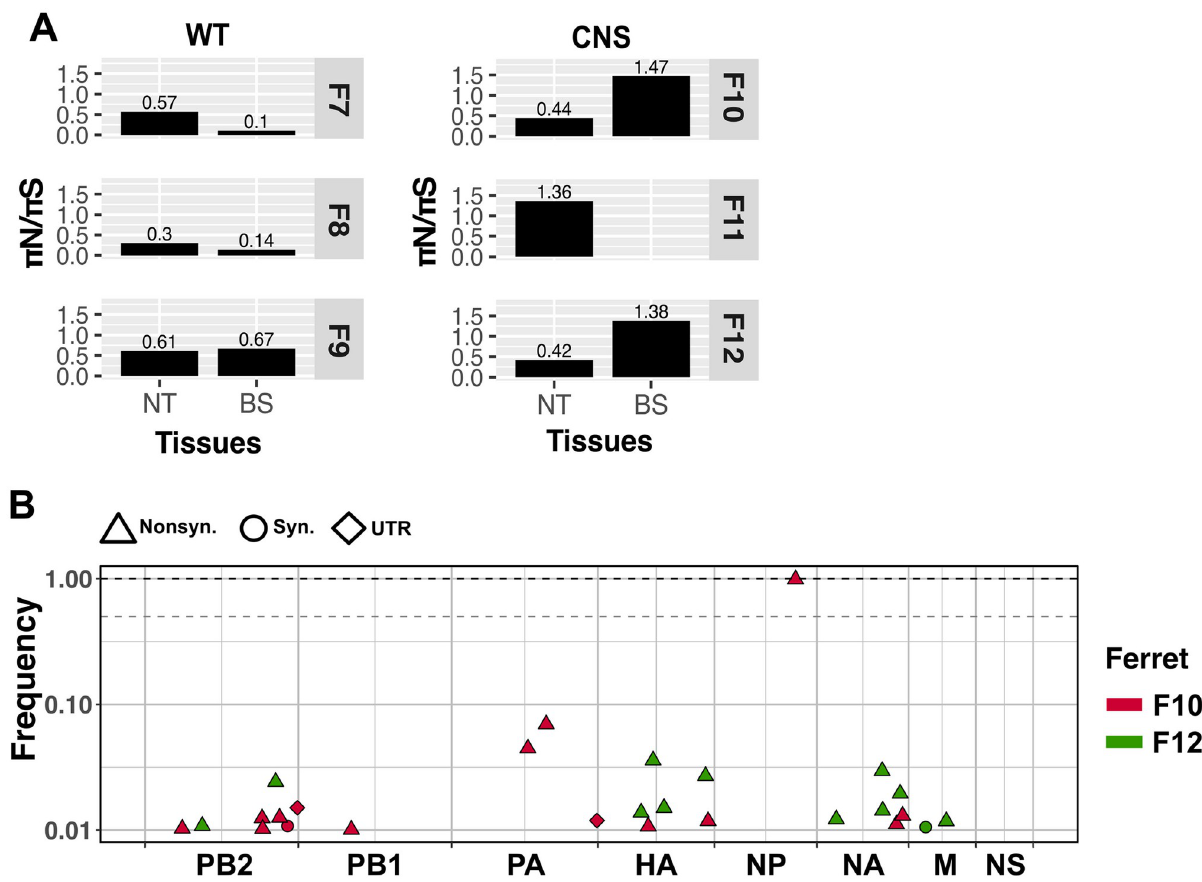
Fig 7. Signs of positive selection for the H5N1-CNS virus are detected in the nasal turbinate and brainstem tissue of infected ferrets at 6 dpi. Positive selection was calculated using the π N/ π S ratio. Values above 1 denote positive selection (A). Variant analysis suggests independent evolutionary events shown by unique variants in brainstem tissue from ferrets F10 and F12 (B). The types of mutation are represented by shapes: synonymous (Syn.) as circles, nonsynonymous (Nonsyn.) as tringles and variants in the untranslated regions (UTR) as diamonds. The segments are shown as concatenated in the x-axis. Dashed grey line shows consensus cut off at 0.5 of frequency whereas dashed black line marks 1 of frequency.